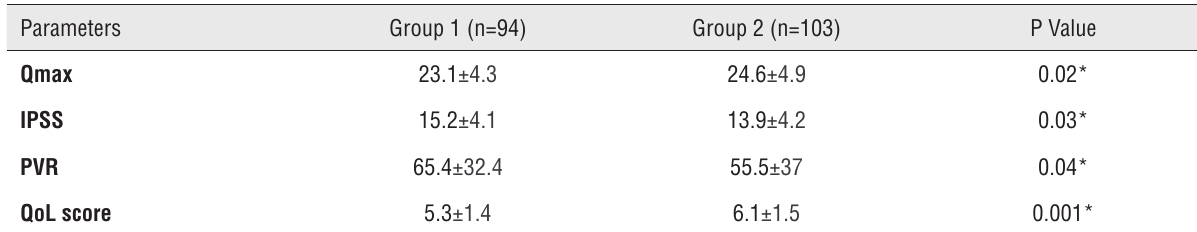
Table 4 - Comparison of uroflowmetry parameters and quality of life index between groups six months after treatment with alpha